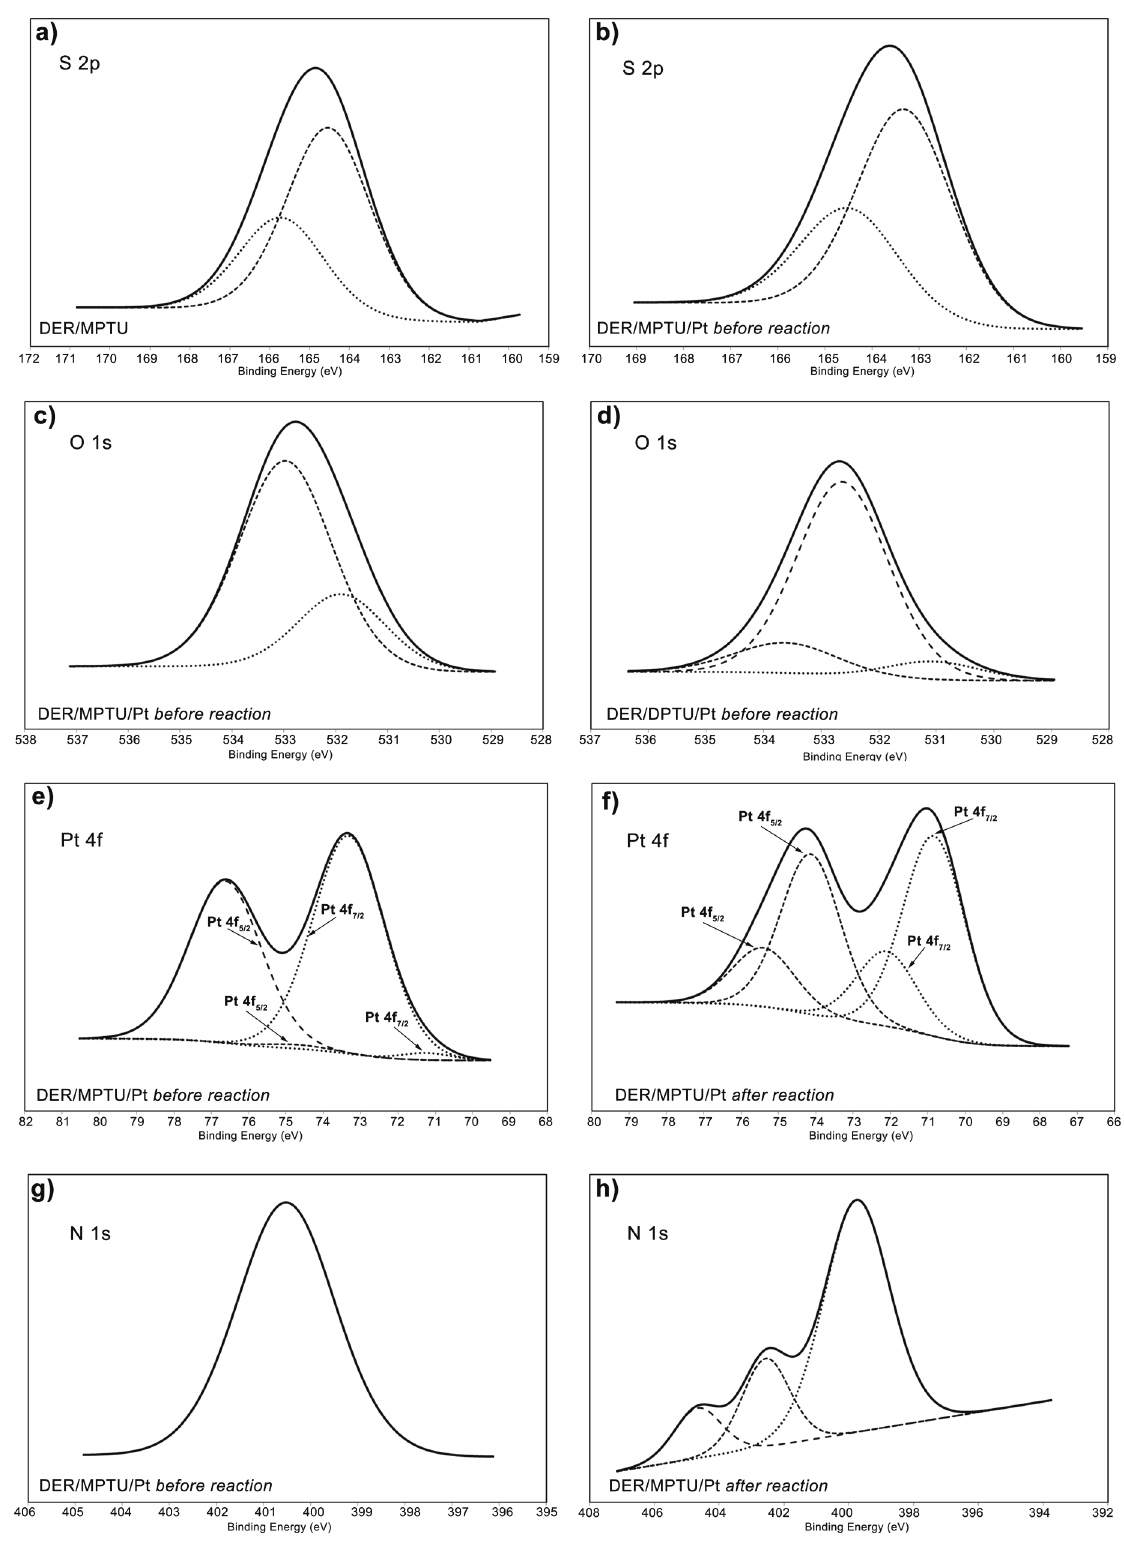
Figure 4: S 2p XPS spectra of DER/MPTU: (a) before, (b) after immobilization of Pt(II) complex, O 1s spectra of: (c) DER/MPTU/Pt; (d) DER/DPTU/ Pt, Pt 4f XPS spectra of DER/MPTU/Pt: (e) fresh catalyst; (f) after use in hydrogenation reaction and N 1s spectra of DER/MPTU/Pt: (g) fresh catalyst; (h) after use in hydrogenation